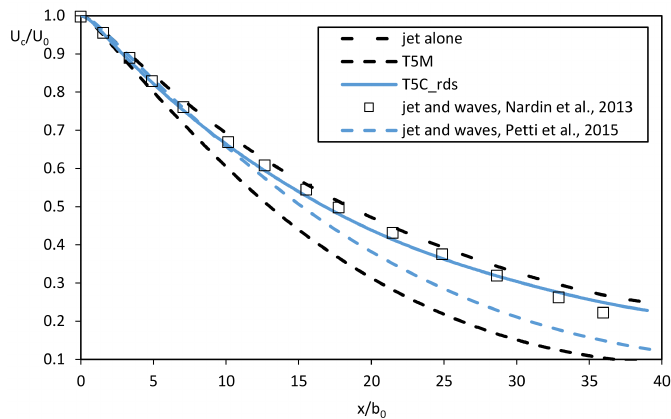
Figure 7. Normalized longitudinal velocity, along the jet centerline, in the case of jet alone and with the superimposed wave propagation with a period of 5 s.